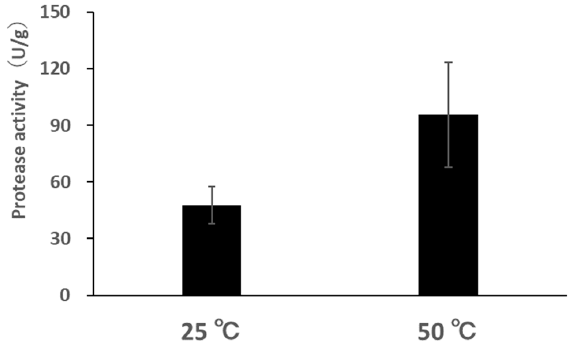
Figure 3. Specific protease activity in internal organs of white sturgeon at different temperatures. Values are mean ( n = 3).